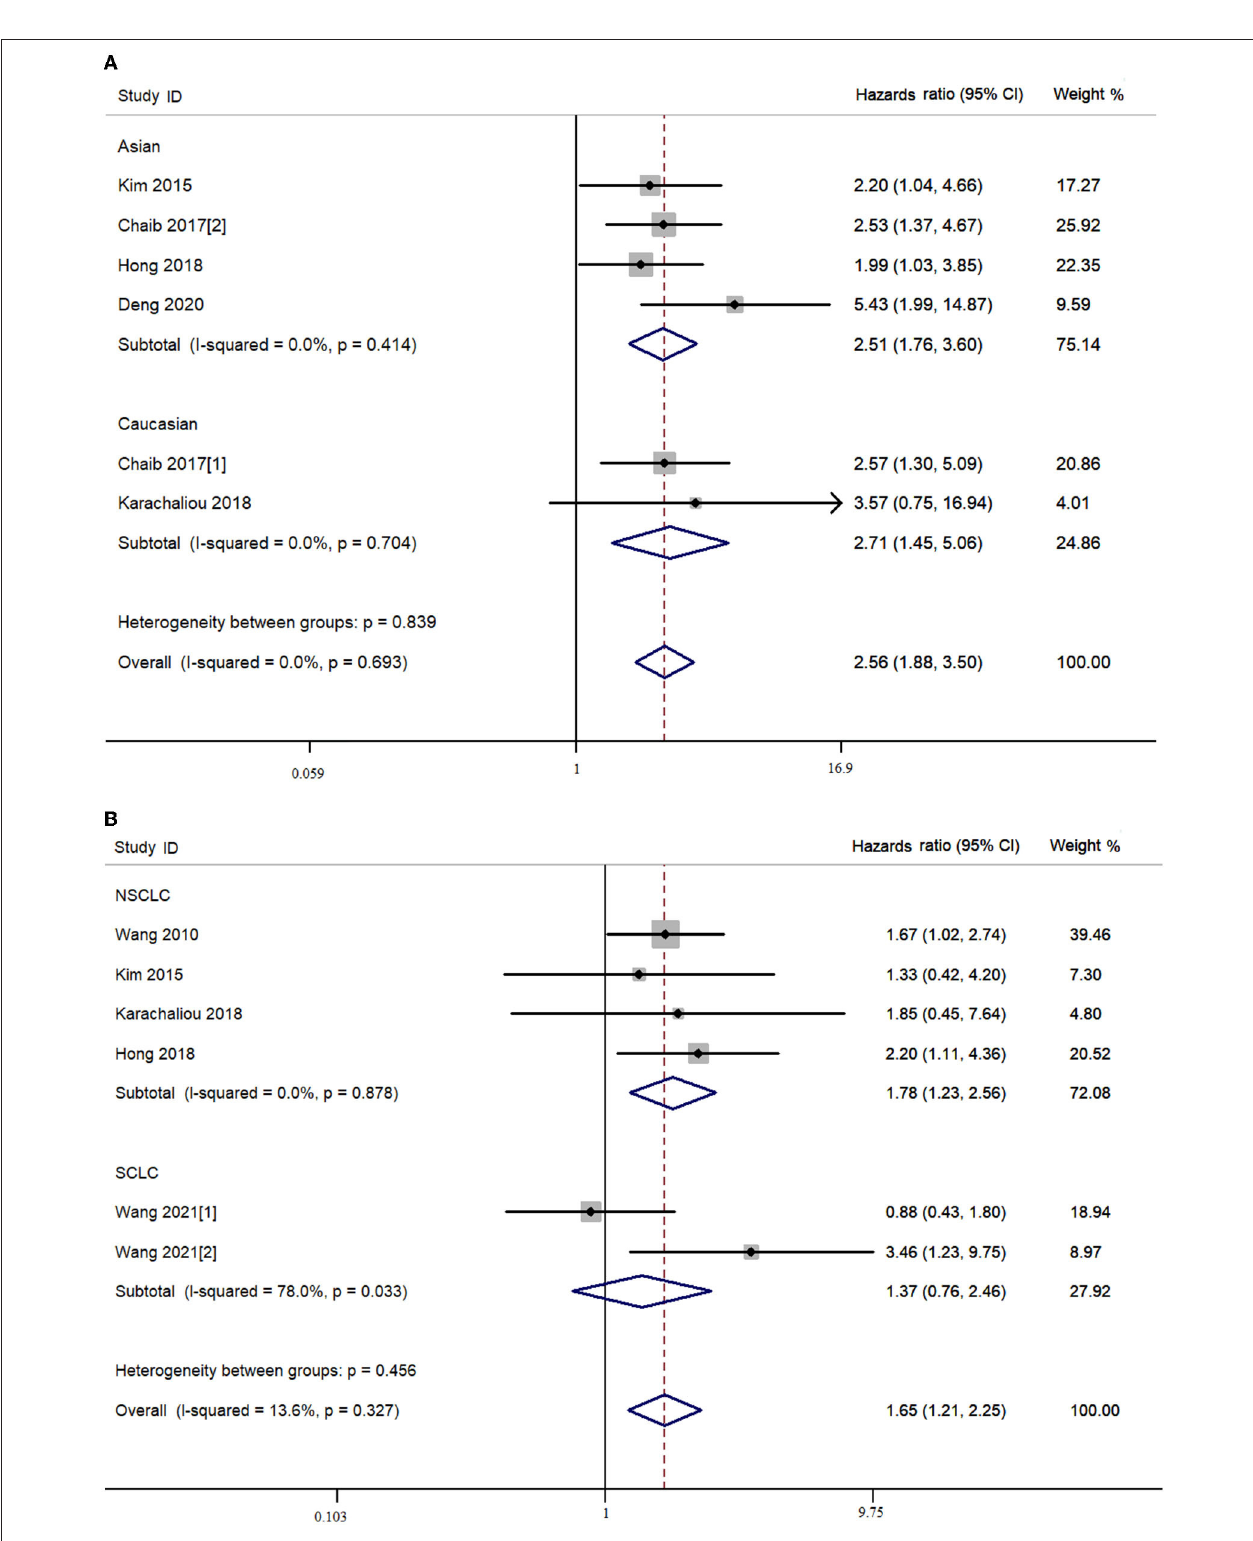
FIGURE 3 | Combined meta-analysis between Yes-associated protein (YAP) expression and survival of lung cancer. (A) Disease-free survival. (B) Overall survival.